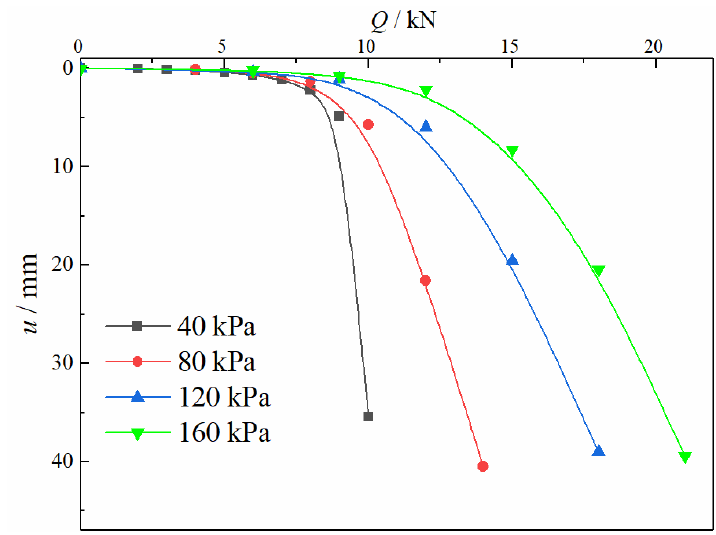
Figure 7. The Q – u curve of the plane shear plate.